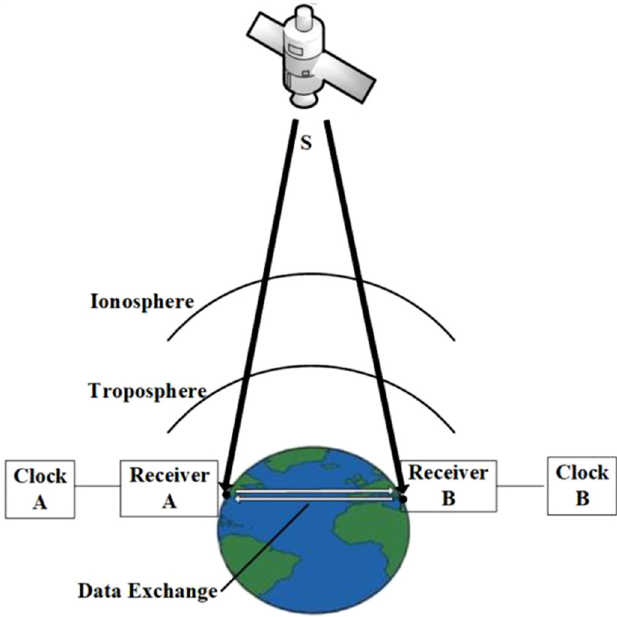
Fig. 2. Principle of GNSS common view (CV) time